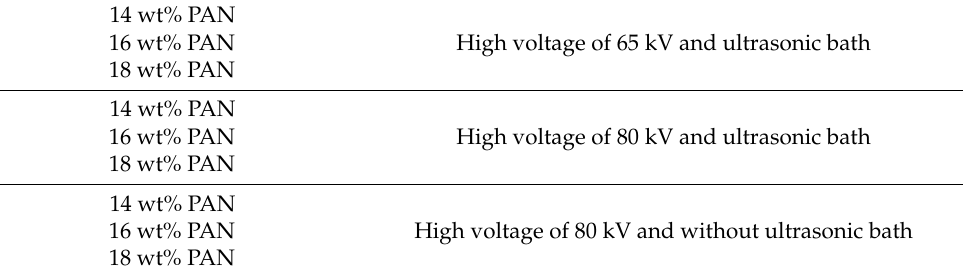
Table 1. Sample overview.